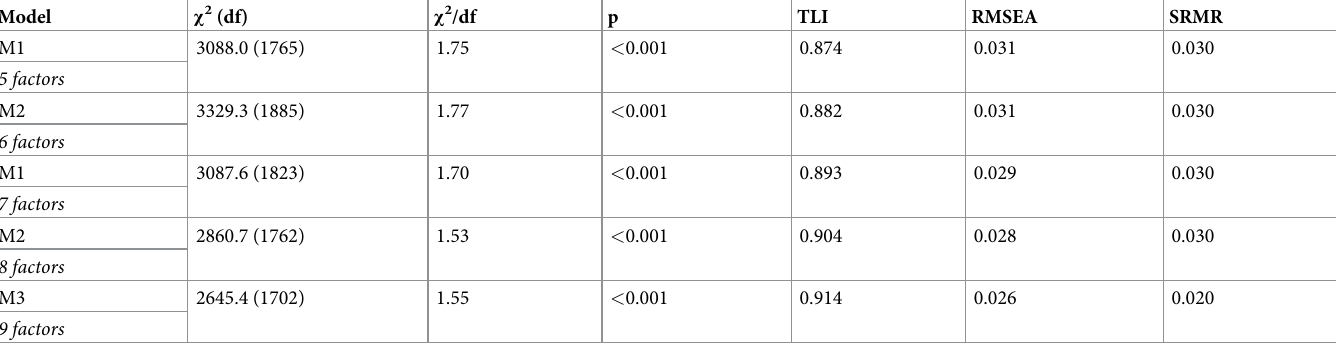
Table 2. Goodness of fit indices for each model (M) of the exploratory factor analyses (EFA) with a 5, 6, 7, 8 and 9 factor structure (N = 774). Model